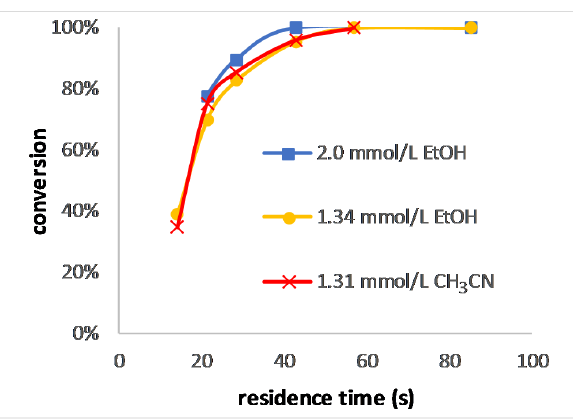
Figure 10: Conversion of citronellol at different concentrations of rose bengal ( D ).